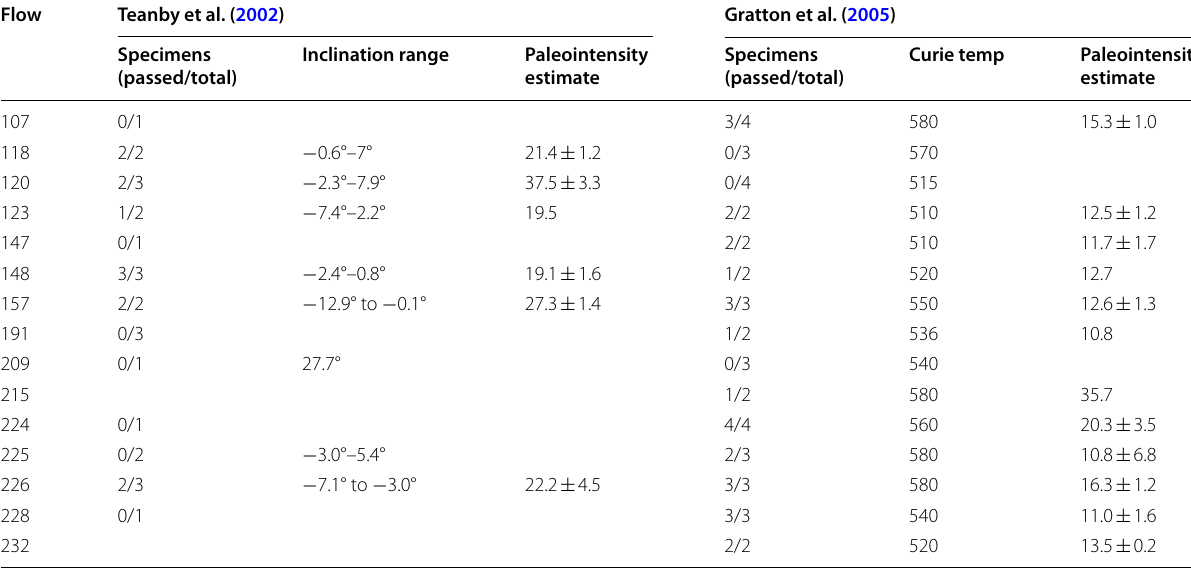
Blank cells indicate no data are available